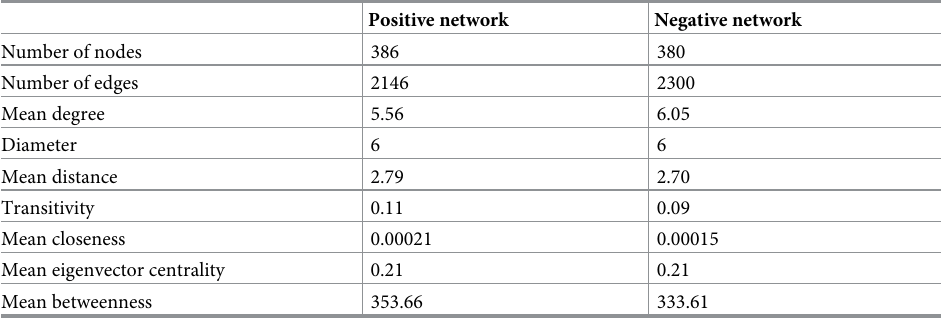
Table 3. Summary statistics of the network with positive edges (positive network) and the network with negative edges (negative